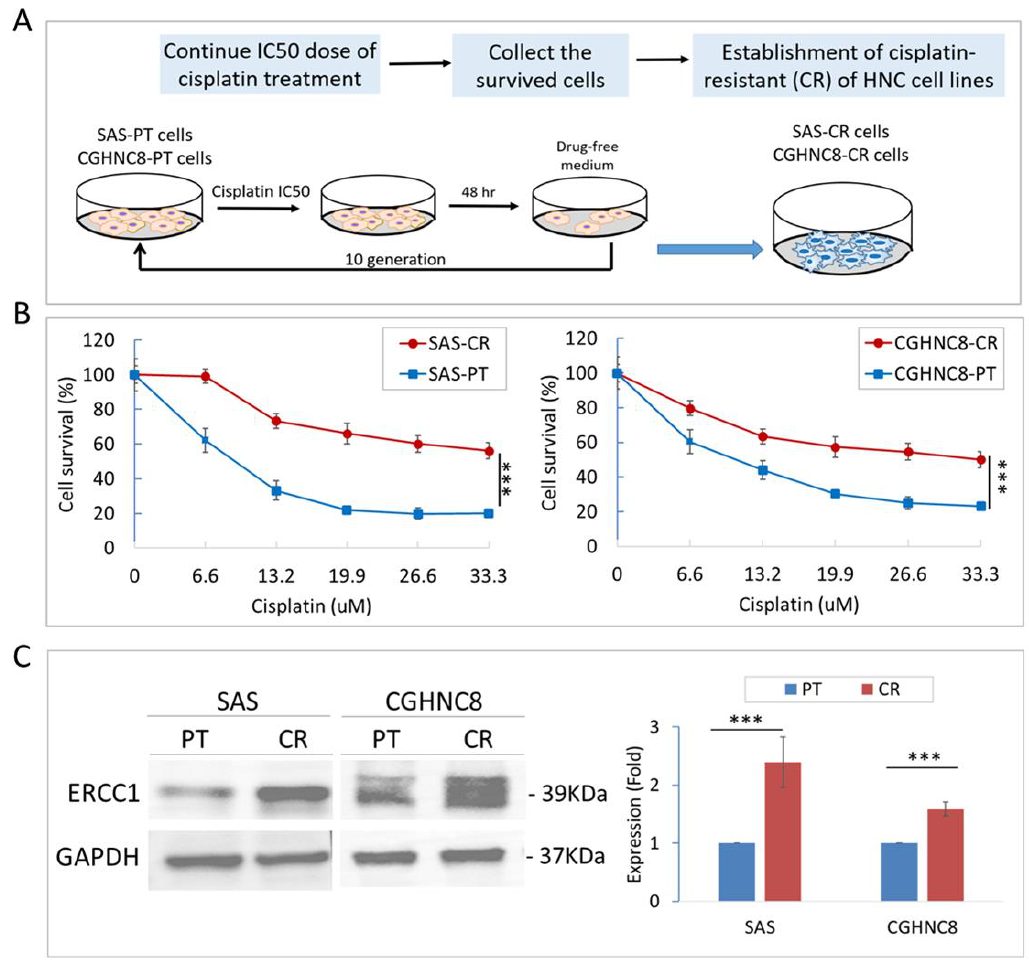
Figure 1. Establishment of cisplatin-resistant (CR) cells derived from head and neck cancer (HNC) cell lines. ( A ) The schematic presentation of the method to establish two CR sublines from two HNC cell lines, SAS and CGHNC8, via the chronic treatment of cisplatin (IC50 doses for 10 generations). ( B ) Viability of HNC parental (PT) cells and the respective CR cells were determined following cisplatin treatment. Cells were treated with various concentrations of cisplatin as indicated (0–33.3 uM) for 48 h, and cell viability was examined by MTS assay. The signal from untreated cells was considered to represent 100% viability. ( C ) The expression of the excision repair cross-complementing rodent repair deficiency, complementation group 1 (ERCC1) molecule was evaluated by immunoblot analysis and quantified by the determination of relative band density. The level of GAPDH expression was used as an internal control to determine relative protein expression. Statistical significance is indicated by p -values (***: p ≤ 0.001). Data are presented as the mean ±